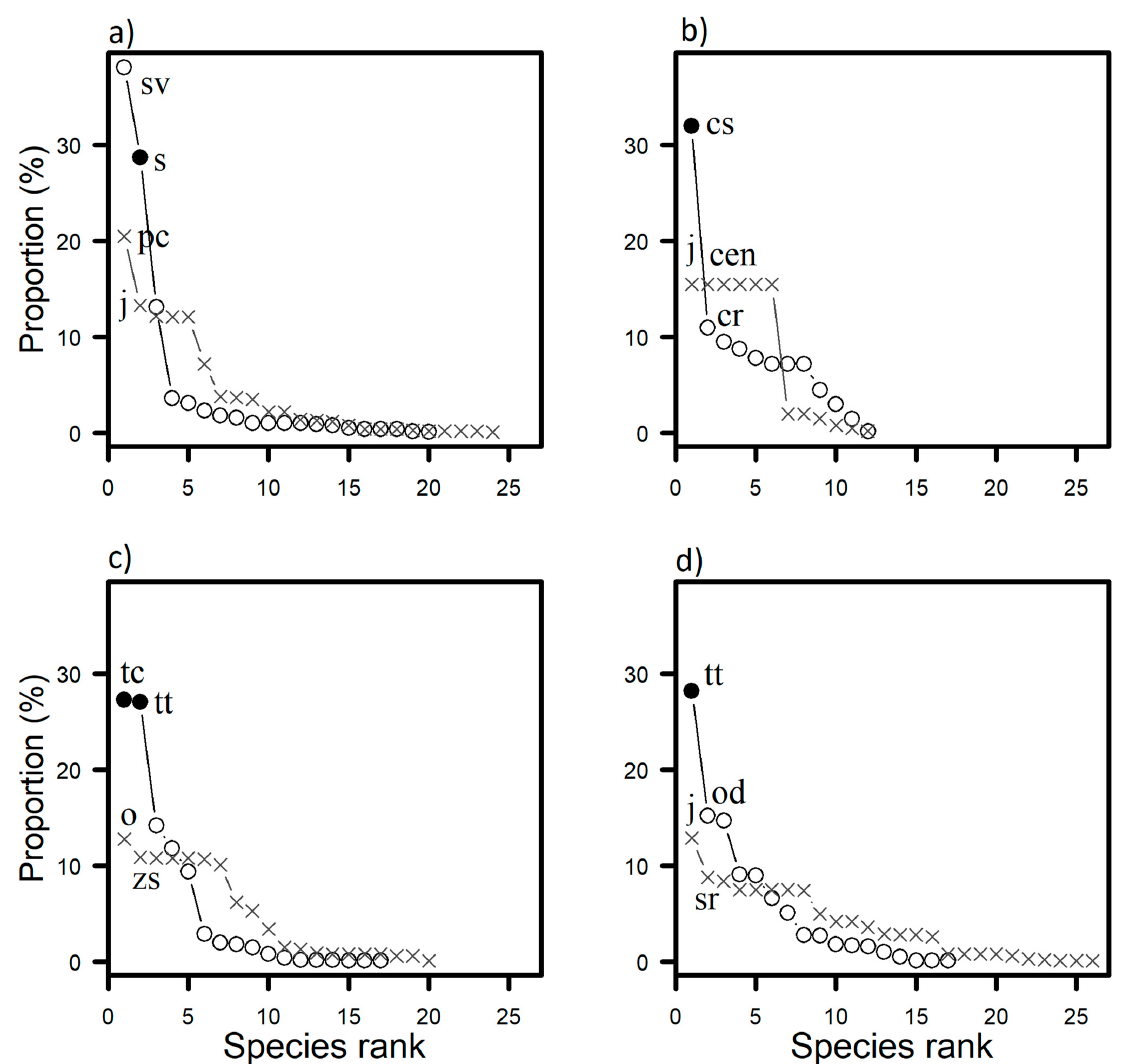
Figure 3. Species rank abundance plots for benthic taxons in four invaded communities represented by the symbol ○ and four not-invaded communities represented by the symbol × on marine tropical rocky shores along the coast of the State of Rio de Janeiro, Brazil at ( a ) Praia Vermelha (PV), ( b ) Praia da Baleia (PB), ( c ) Ilha de Âncora (IA) and ( d ) Ilha Comprida (IC). AS are represented by the symbol ● . sv = Sargassum vulgare , s = Sansibia sp., pc = Palythoa caribaeorum , j = Jania adhaerens , o = Echinometra lucunter , cs = Caulerpa scalpelliformis , cen = Centroceras sp., c = Caulerpa racemosa , tt = Tubastraea tagusensis , tc = Tubastraea coccinea , zs = Zoanthus sociatus , od = Obelia dichotoma , sr = Scopalina ruetzleri . According to the diversity indices, not-invaded communities had greater diversity than invaded ones, except for the PB site that had similar values in both communities. Under the AS removed scenario, there was no change in the general pattern of the results of the taxonomic diversity over sites. PB once again stood out in this respect as the Simpson, Fisher and Shannon indices, which were not different between invasion states but were reduced under the AS removed scenario. According to these indices, the diversity was greater in the not-invaded communities and under the AS removed scenario it increased for the three other sites (Figure 4) (Table S3).